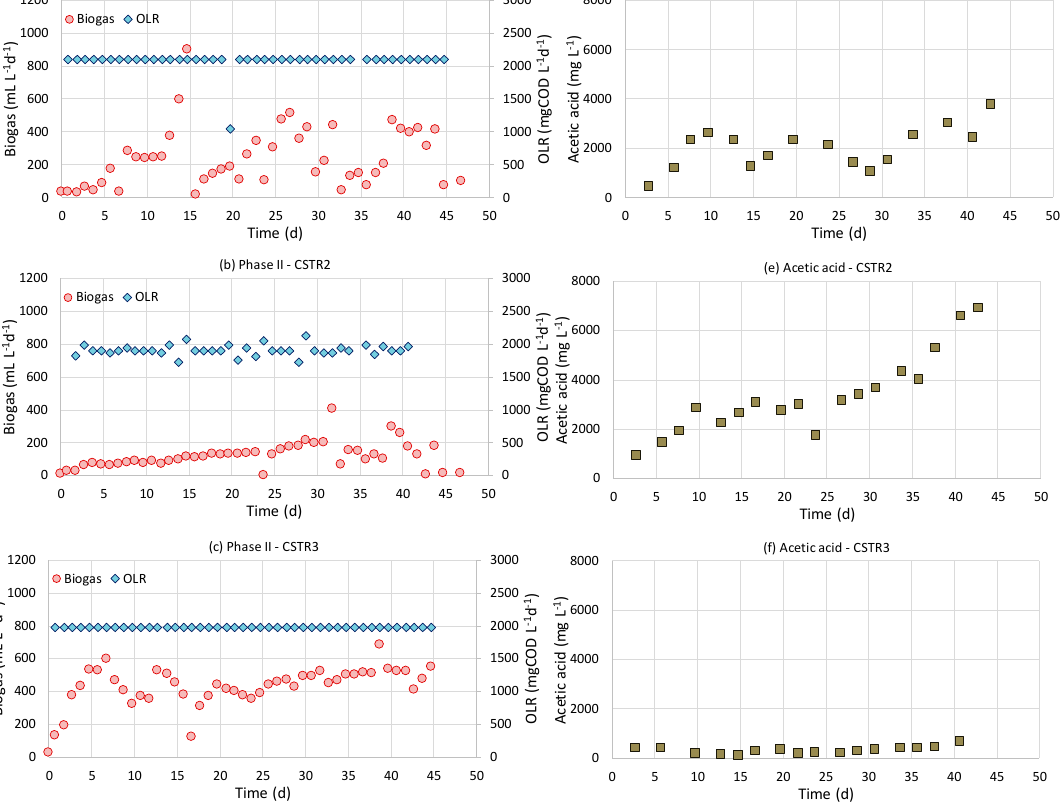
Figure 3. Biogas production rate compared to organic loading rate in three CSTRs fed on sunflower heads during operational phase II ( a ) CSTR1 (NaOH pretreated, 4% NaOH), ( b ) CSTR2 (NaOH pretreated, 8% NaOH), ( c ) CSTR3 (untreated) and acetic acid degradation profiles in ( d ) CSTR1, ( e ) CSTR2, ( f ) CSTR3.